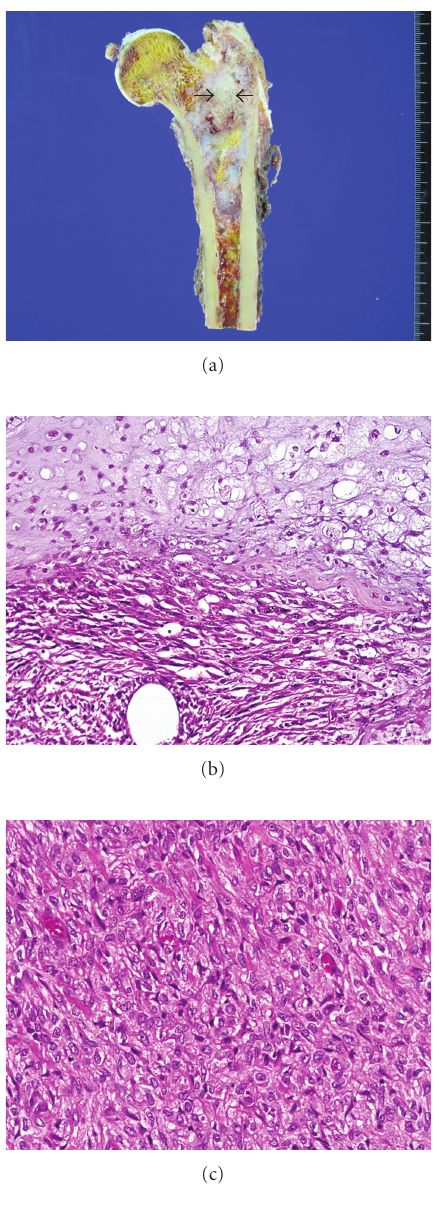
Figure 11: (a) An ill-demarcated lobulating firm mass (8.5 × 4.0 × 4.0 cm) in the proximal femur. Most of the mass which is white to bluish gray is conventional chondrosarcoma. The yellowish gray area in the center (arrows) is dedi ff erentiated area. (b) The abrupt transition between conventional CHS and dedi ff erentiated component. (c) The dedi ff erentiated component consisting of malignant spindle cells without matrix formation (malignant fibrous